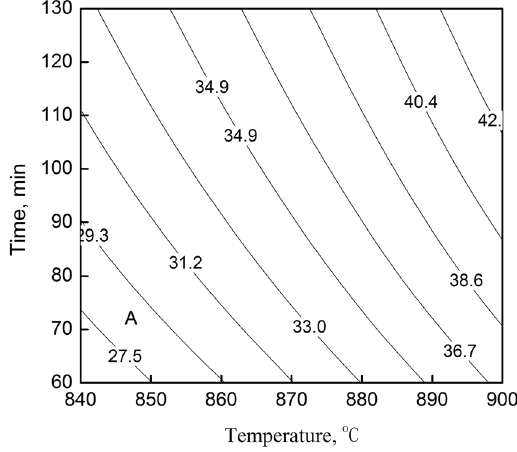
Figure 8. Distribution of the average grain sizes during the heating process ( μ m).